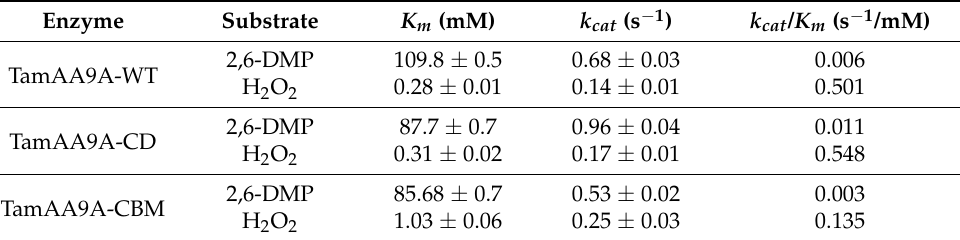
Table 1. Kinetic constants of TamAA9A-WT, TamAA9A-CD, and TamAA9A-CBM for H 2 O 2 and